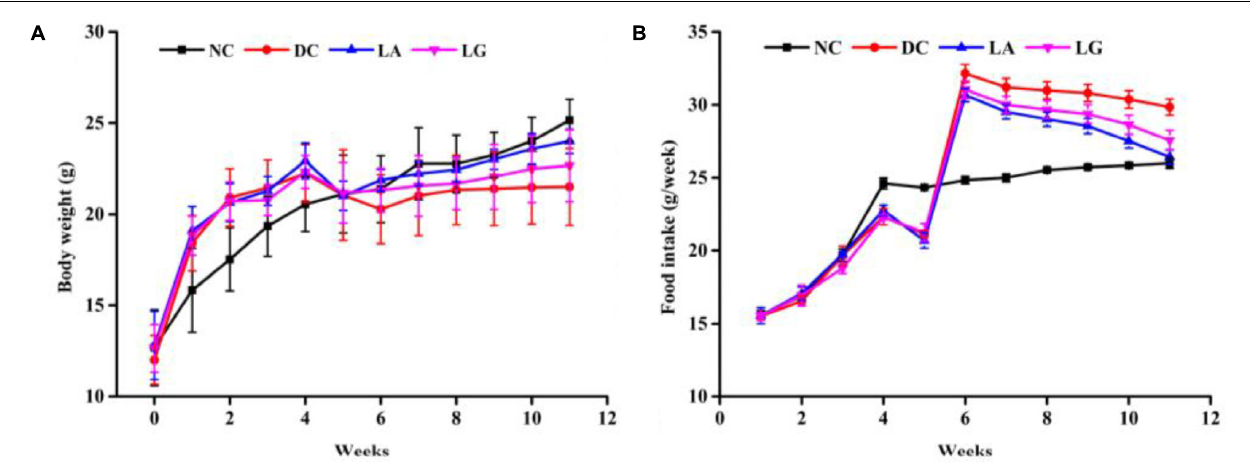
FIGURE 3 | Effect of probiotics feeding on (A) body weight and (B) food intake. NC, normal control group; DC, diabetic control group; LG, DC plus L. rhamnosus GG; LA, DC plus L. acidophilus KLDS1.0901.